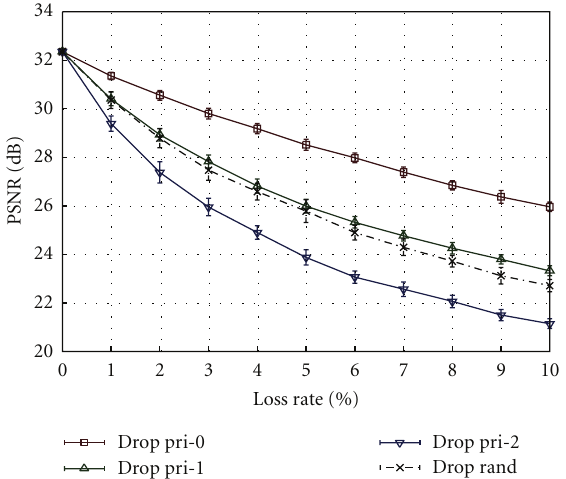
Figure 4: Mean Y-PSNR for the Stefan video sequence when dropping packets with di ff erent